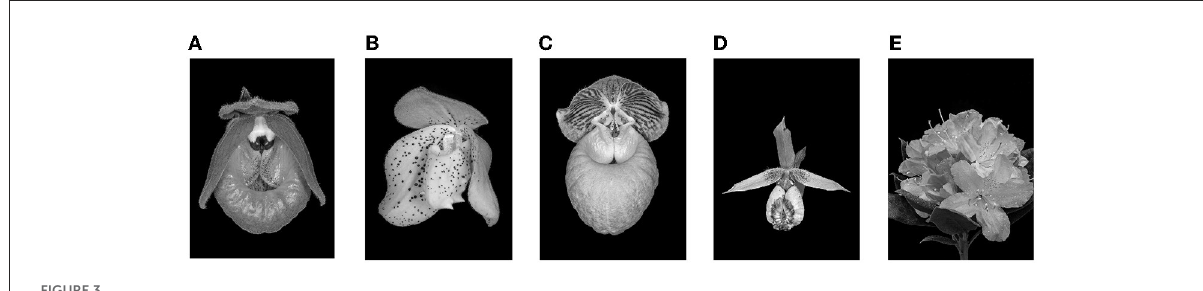
FIGURE3 Experimental materials: flowers (A–E) .